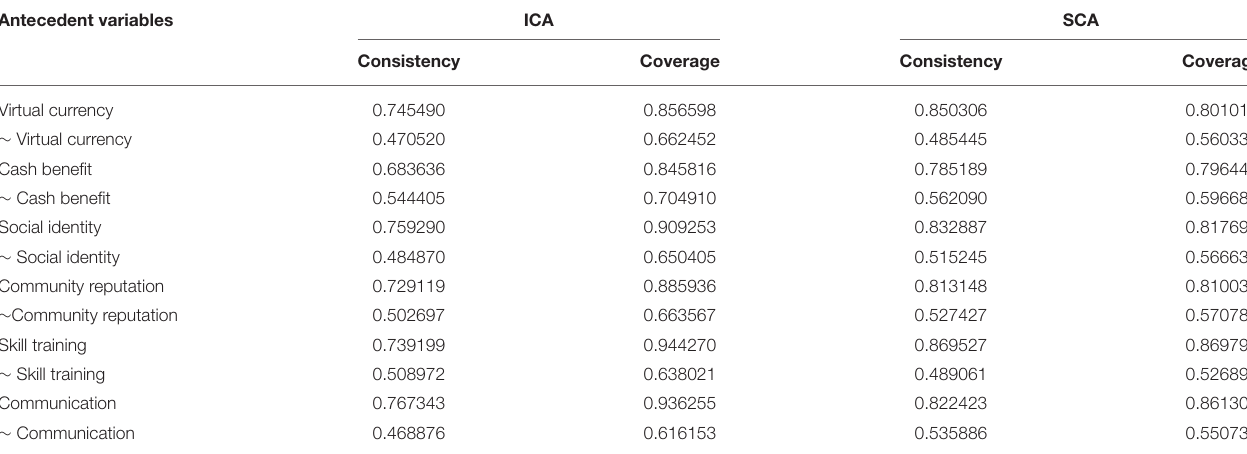
TABLE 3 | Results of the analysis of the necessary conditions.